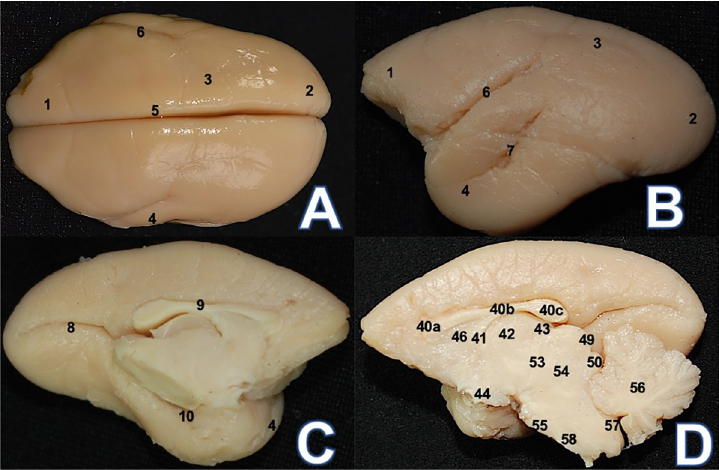
Fig 1. Callithrix penicillata (CP1) encephalon. (A) Superior view: 1. Frontal lobe 2. Occipital lobe 3. Parietal lobe 4. Temporal lobe 5. Sagittal/longitudinal fissure 6. Lateral sulcus (B) Lateral view: 7. Superior temporal sulcus (C) Medial view: 8. Calcarine sulcus 9. Sulcus of the corpus callosum 10. Hippocampal sulcus; (D) Medial view: 40a. corpus callosum genu 40b. corpus callosum trunk 40c. corpus callosum splenium 41. Fornix 42. Thalamus 43. Epiphysis 44. Hypothalamus 46. Septum pellucidum 49. Superior colliculus 50. Inferior colliculus 53. Metathalamus 54. Mesencephalon 55. Pons 56. Cerebellum 57. Ventriculus quartus 58.